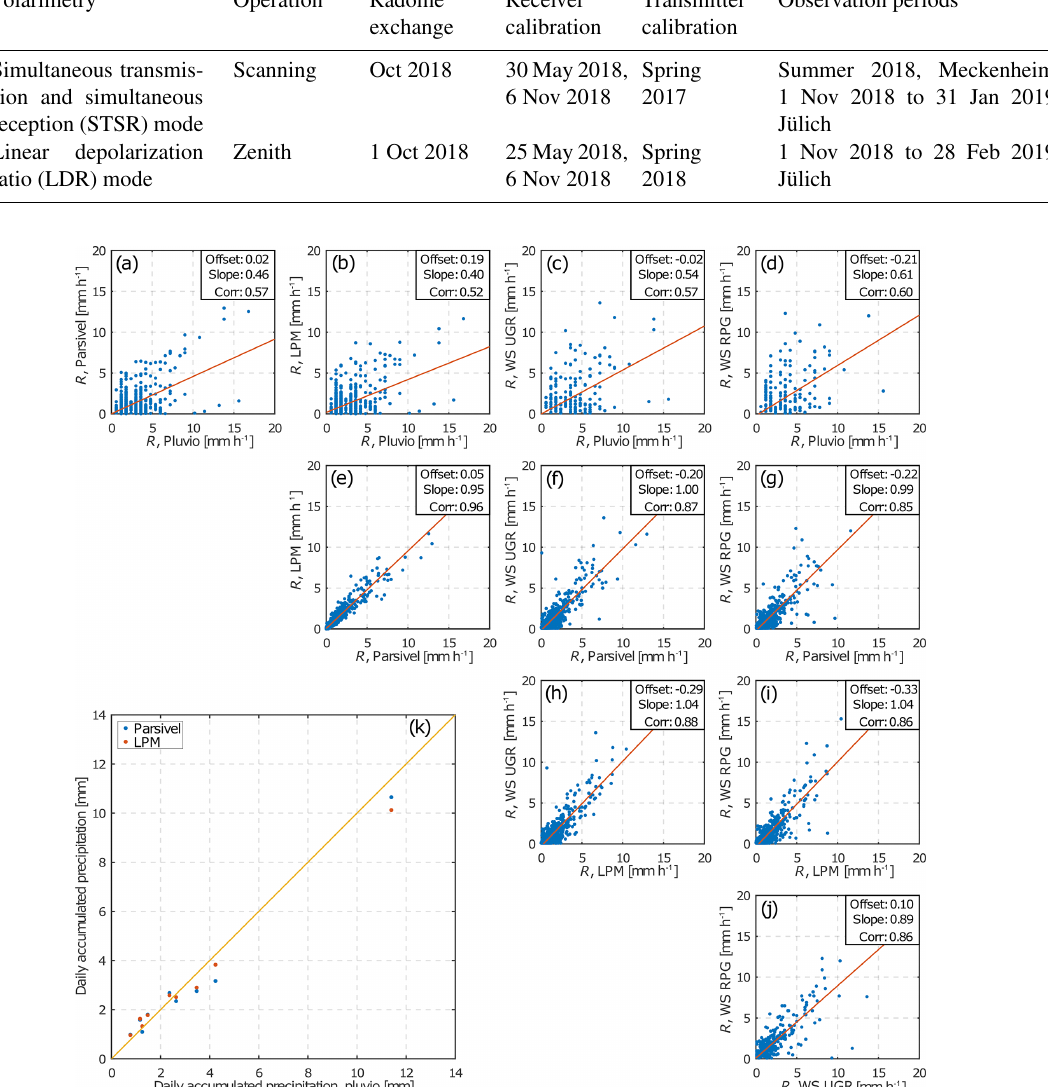
Figure 3. A comparison of 1min rain rates observed by Pluvio, Parsivel, LPM, and the two Vaisala WXT520 weather stations attached to the radars (a–j) . The weather stations of radars 1 and 2 are denoted as WS UGR and WS RPG, respectively. The data set from the TRIPEX-pol campaign (1 November 2018 to 6 December 2018) contains 391min of rainfall detected by all sensors simultaneously. Each subplot contains the estimated offset and the slope of a linear fit (red line) and the Pearson correlation coefficient. Panel (k) shows a comparison of the daily accumulated precipitation from Pluvio, Parsivel, and LPM from 10 precipitating days. The yellow line is the one-to-one relation.